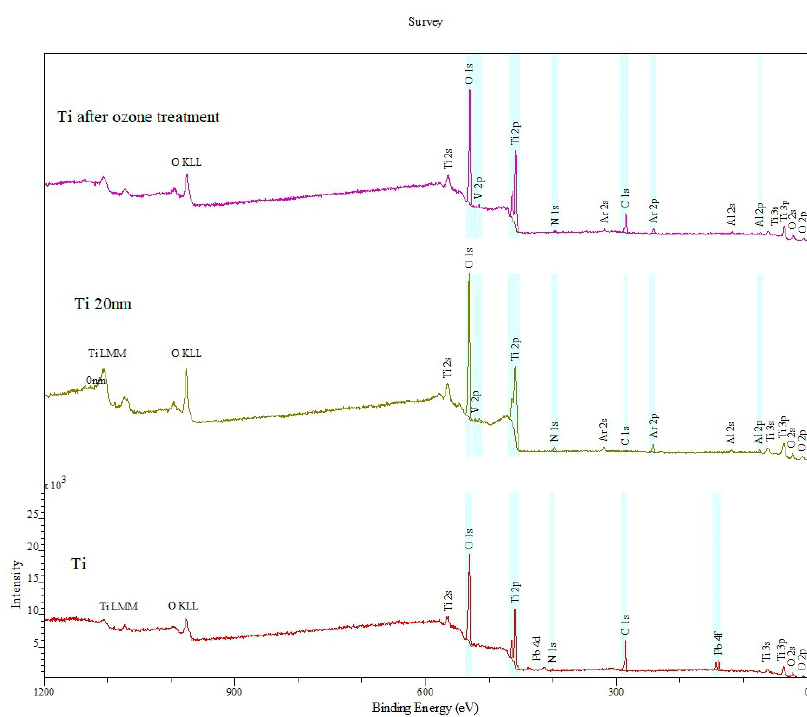
Figure 6. Comparative kit of XPS broadband spectra of Ti6Al4V titanium alloy samples in the following order: A spectrum of titanium alloy before ozone treatment (Ti), after plasma cleaning (Ti 20 nm) and after ozone treatment (Ti after ozone treatment).